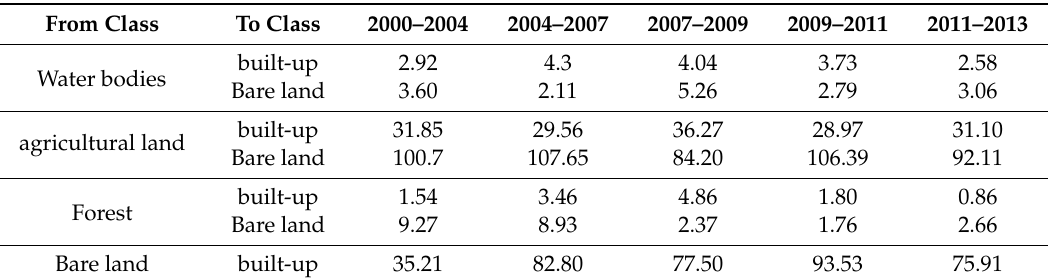
Figure 7. Urban LULC maps in the study area from time series images: ( a ) 2000; ( b ) 2004; ( c ) 2007; ( d ) 2009; ( e ) 2011; and ( f ) 2013. Table 6. Major LULC conversions from 2000 to 2013 (km 2 ).